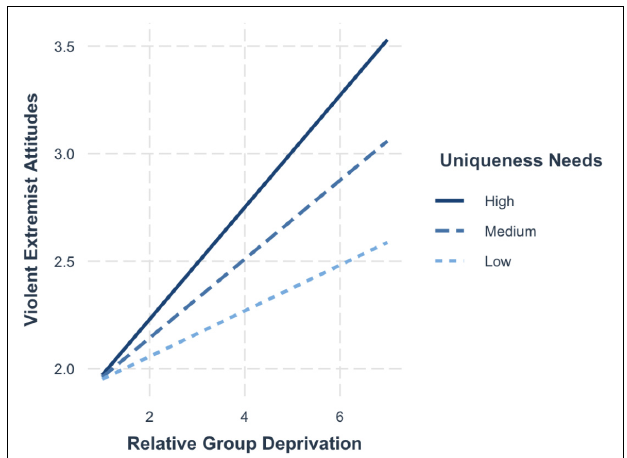
FIGURE 1 | Simple slopes for group deprivation and need for uniqueness on violent extremist attitudes.